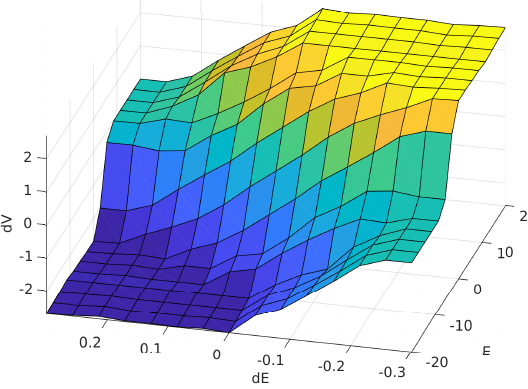
Figure 7. Relationship between the inputs: Error variation ( dE ) and error ( E ); and the output: voltage variation ( dV